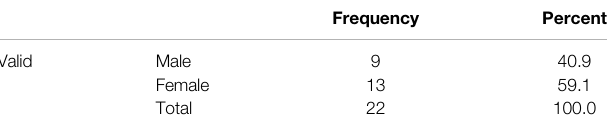
TABLE 4 | Sample demographic by